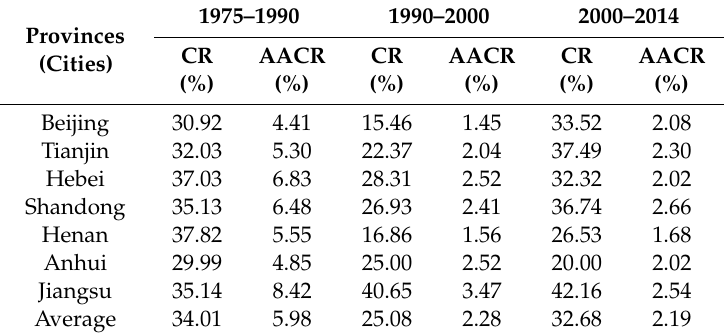
Table 3. Dynamics of the built-up land in floodplains (BLF) in di ff erent periods.